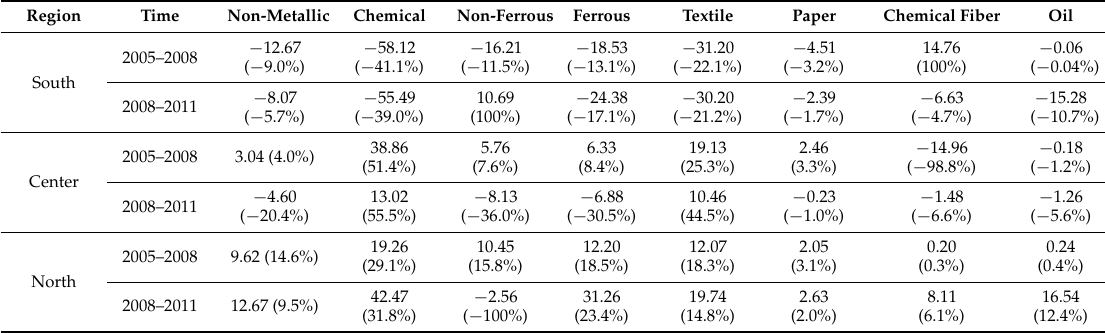
Table 6. D values in individual sectors and the percentage for the total positive and negative D values during 2005–2008, 2008–2011 and 2000–2011 (unit: RMB billion). Region Time Non-Metallic Chemical Non-Ferrous Ferrous Textile Paper Chemical